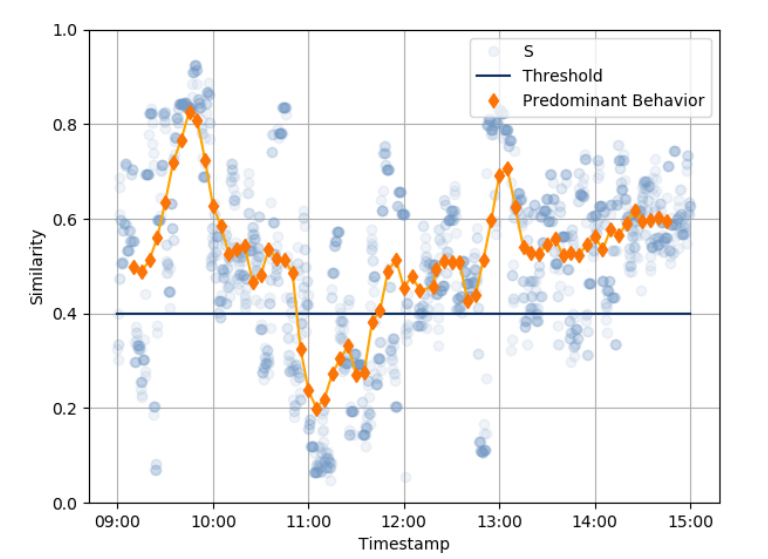
Figure 9. Applying the moving-average filter to represent a predominant behavior with a threshold T =